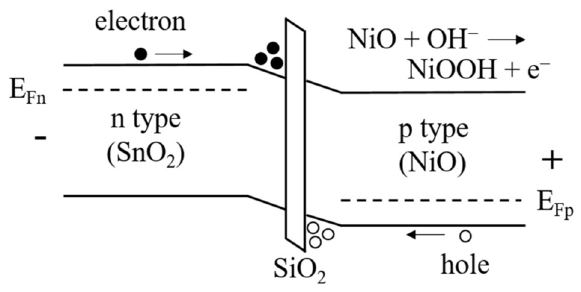
Figure 13. Energy band diagram of all-solid-state EC device with SiO 2